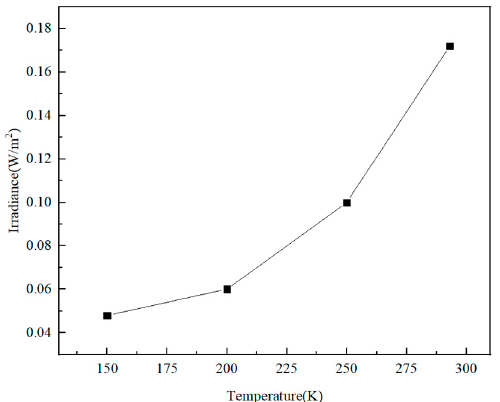
Figure 12. The stray light irradiance of the image plane at different rear optical path temperatures. Through the optimization of the surface emissivity of the key surface and partial temperature control, the internal radiation of the system can be controlled in a lower range at a lower cost.